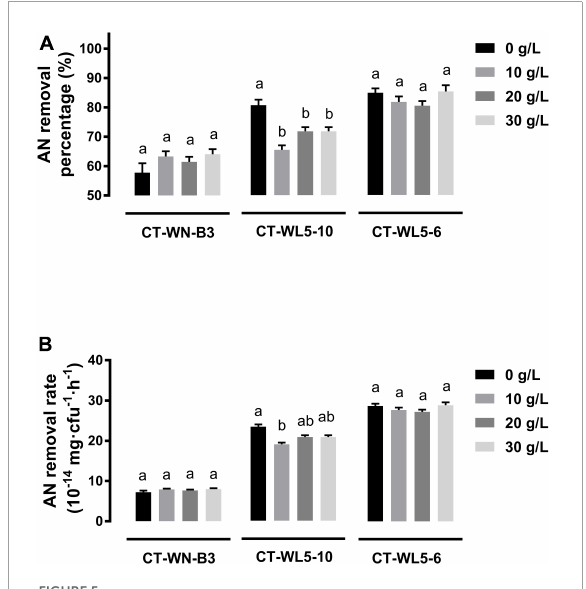
FIGURE5 Salinity effect on AN removal. The AN removal percentage (A) and AN removal rate (AN quantity per cell per hour) (B) of strains after 24 h incubation in media with different salinities were shown. Values in each strain group with different superscripts in (A,B) were significantly different ( P < 0.05). Columns in different colors represent different NaCl concentrations.